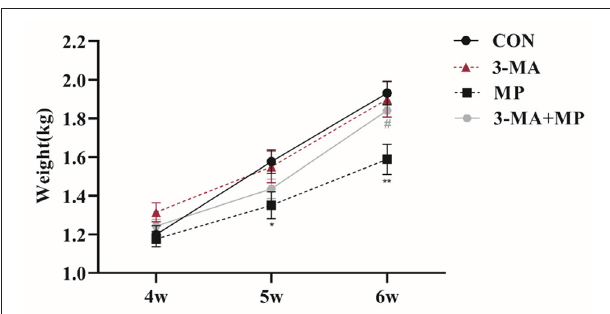
FIGURE 2 | Body weight at 3 aging stages (4, 5, 6 wk) for each group. Treatment with 3-MA caused no significant difference in body weight ( P > 0.05). Broilers were co-treated with MP and 3-MA. * P < 0.05 vs. control group; ** P < 0.01 vs. control group; # P < 0.05 vs. MP group. 3-MA, 3-methyladenine; MP,